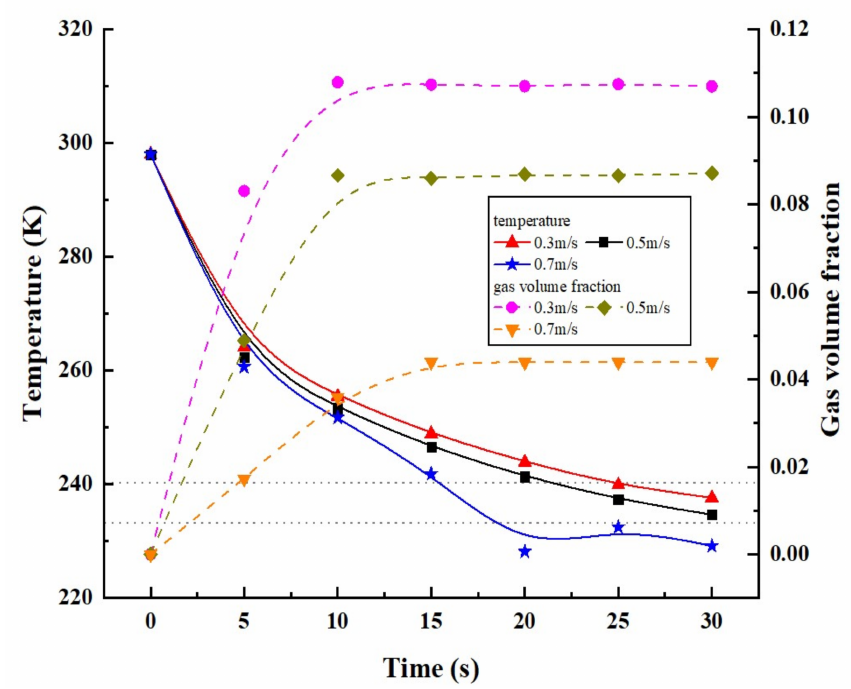
Figure 13. The influence of different refrigerant flow rates on pre-cooling temperature and R23 gas volume